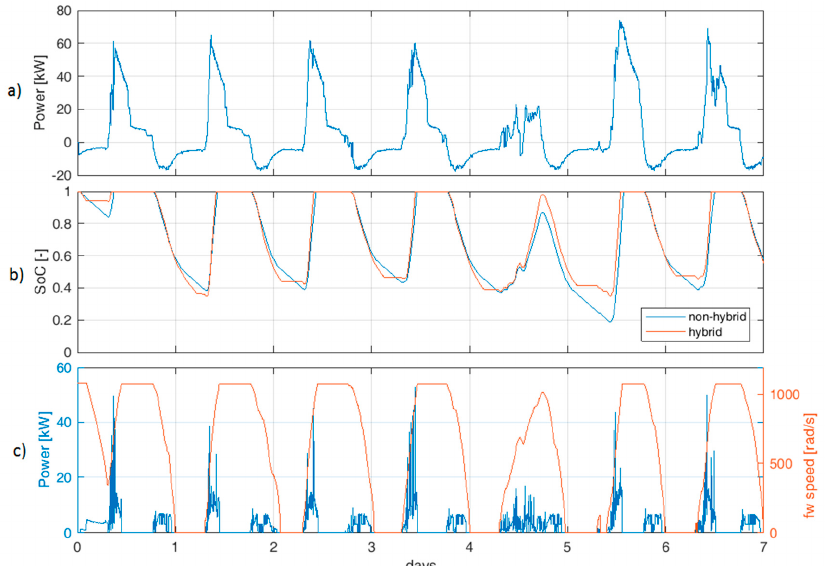
Figure 2. Main assessed parameters for configurations 1 (hybrid) and 2, respectively: a ) power difference between PV production and 𝑳 𝑲𝒊𝒕 load profile, b ) battery SoC in hybrid and non-hybrid cases, c ) flywheel power (absolute value) and speed (hybrid case)